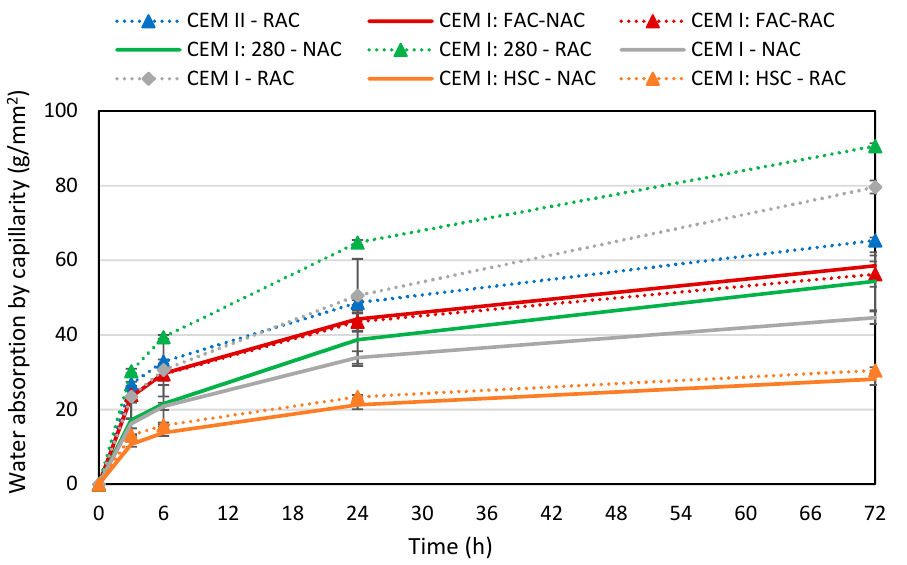
Figure 3. Water absorption by capillarity.